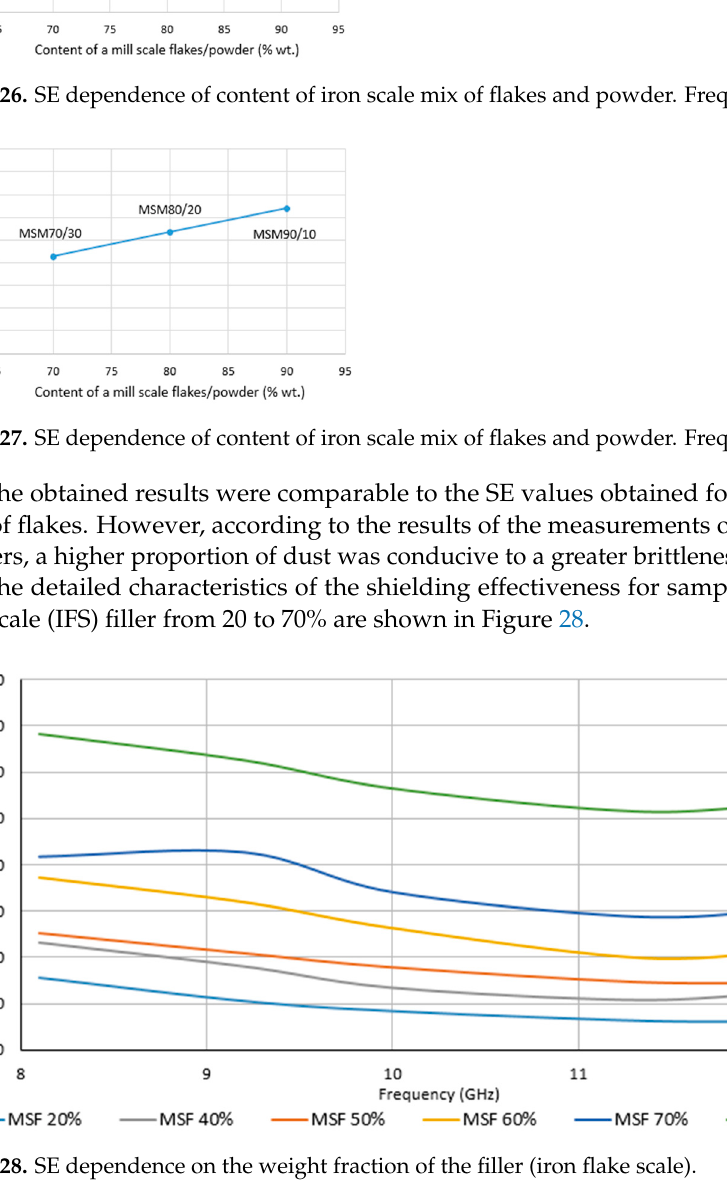
Table 2. EMI shielding properties of different composite materials reported in the literature. Materials (thickness) Frequency range SE (dB) Ref.